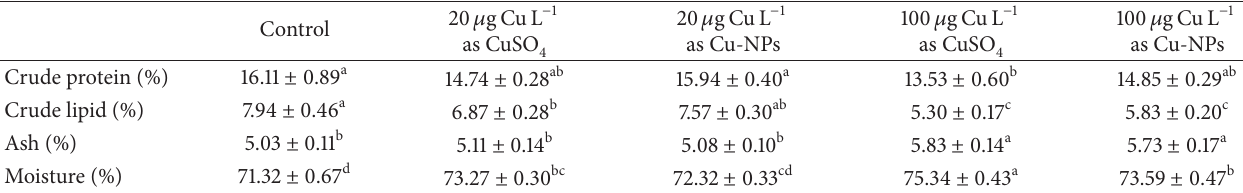
on whole-body composition (% on wet weight basis) of juvenile Epinephelus coioides after 25-day 4